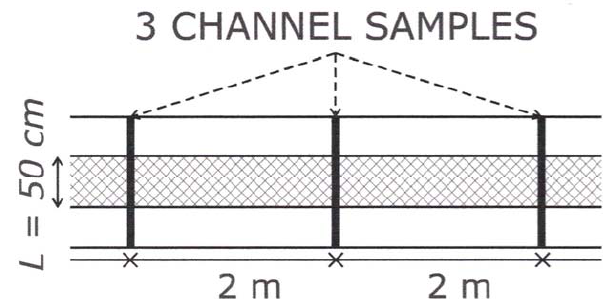
Fig. 4. Schematic representation of channel sampling in Pulacayo Mine. Successive channel samples along horizontal mining drift on 446-m level were 1.3-m long and 2-m apart. The Tajo vein, which is 0.5-m wide on average, consists of massive sulphide (hatched pat- tern) but wall rock on both sides of the vein contained disseminated 30 sulphide and stringers of sulphide ore. Anticipated stoping width was 1.3-m but “effective” channel sample width ( L) was set equal to width of vein ( = 0.5m). Lag distance( h) is 2m or multiple of